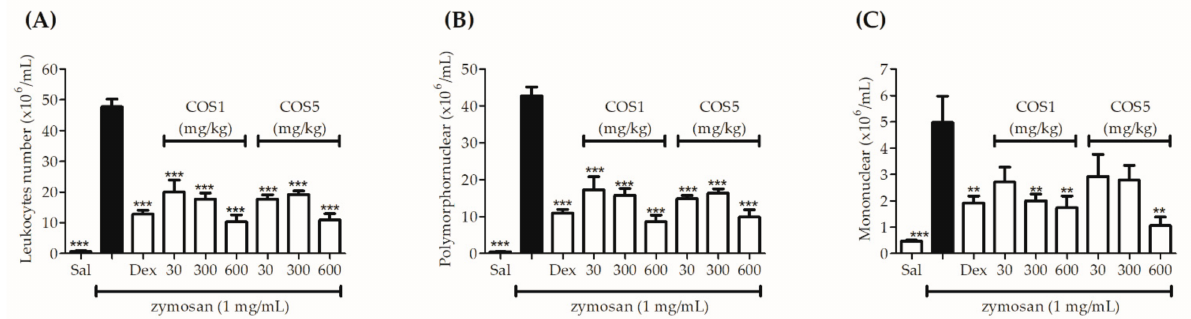
Figure 7. Effects of COS1 and COS 5 in the air pouch model at 30, 300, and 600 mg/kg doses on leukocyte migration. The total leukocyte count ( A ), differential count of the polymorphonuclear cells ( B ), and differential count of the mononuclear cells ( C ). Note: *** p < 0.001 and ** p < 0.01 compared to the zymosan group (black column). Sal: saline solution (0.9 mg/mL); Dex: dexamethasone (2 mg/kg).